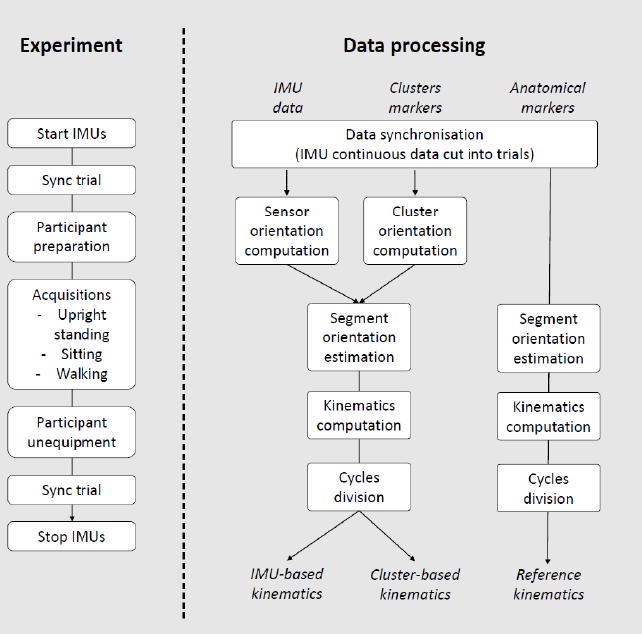
Figure 3. Flowchart of the experimental procedure and data processing main steps.